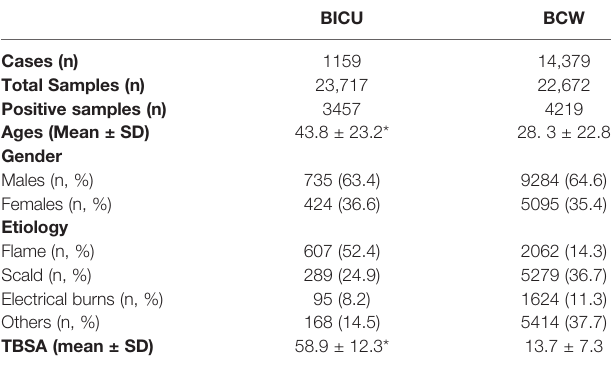
TABLE 1 | Clinical feature of burn patients in BICU and